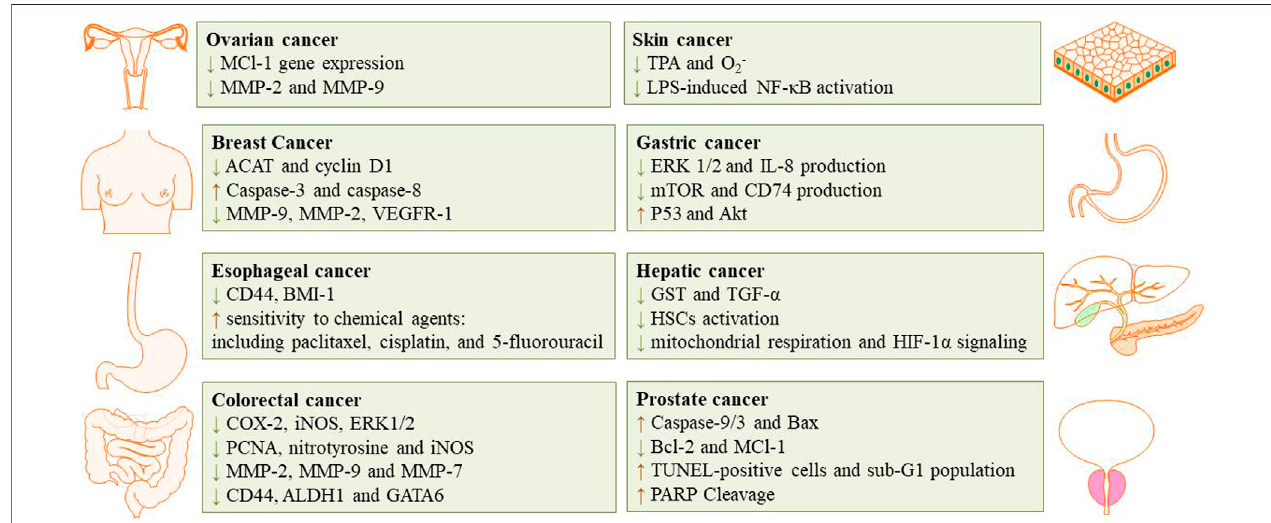
FIGURE 2 | The inhibition effects of auraptene in different type of cancer.